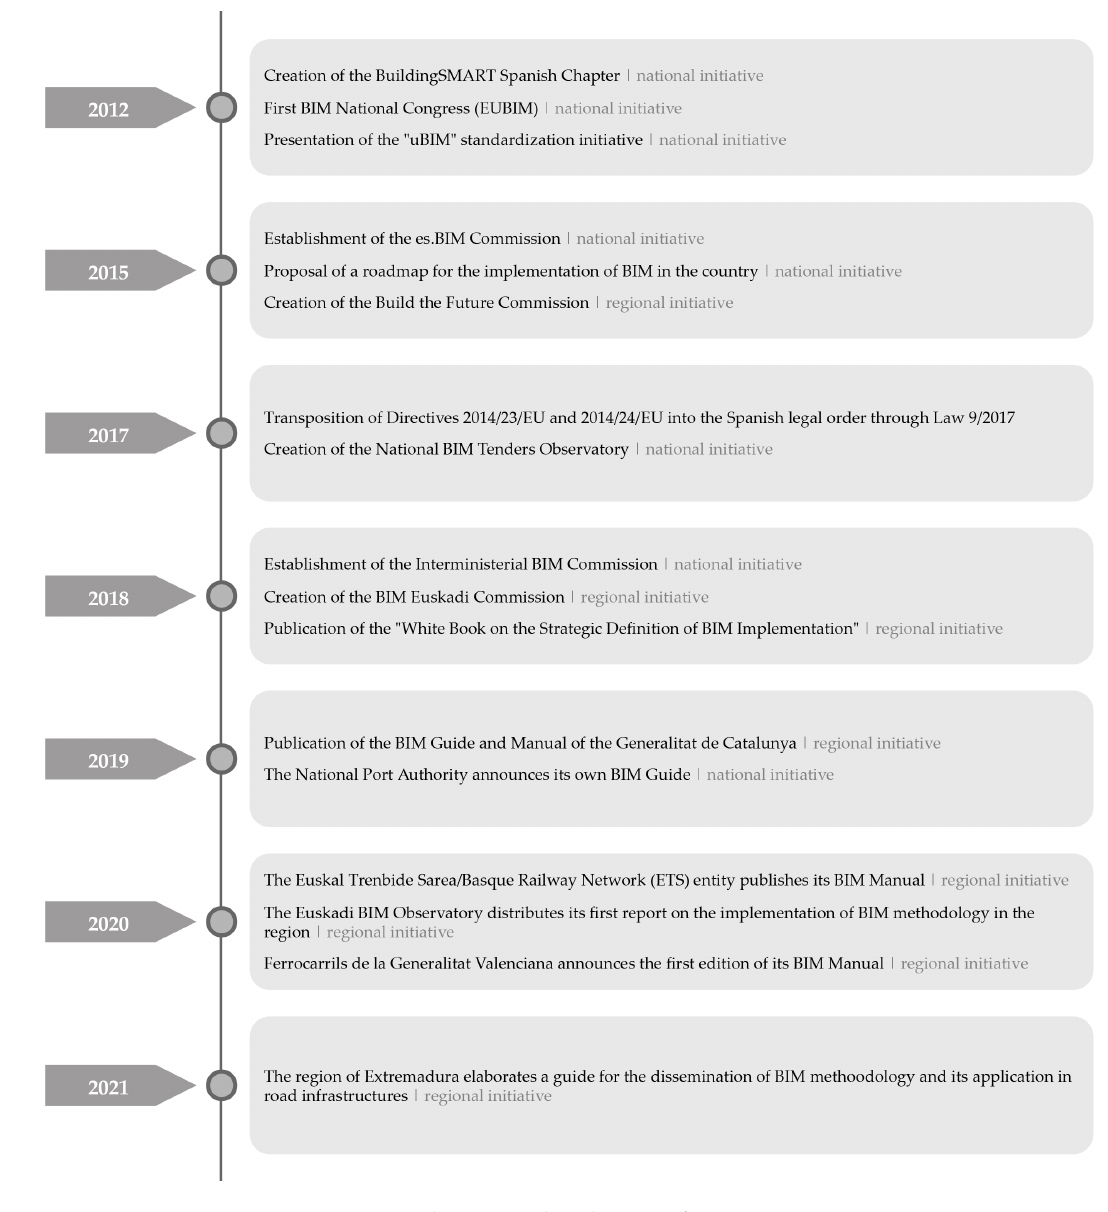
Figure 1. Advances in the adoption of BIM in Spain.